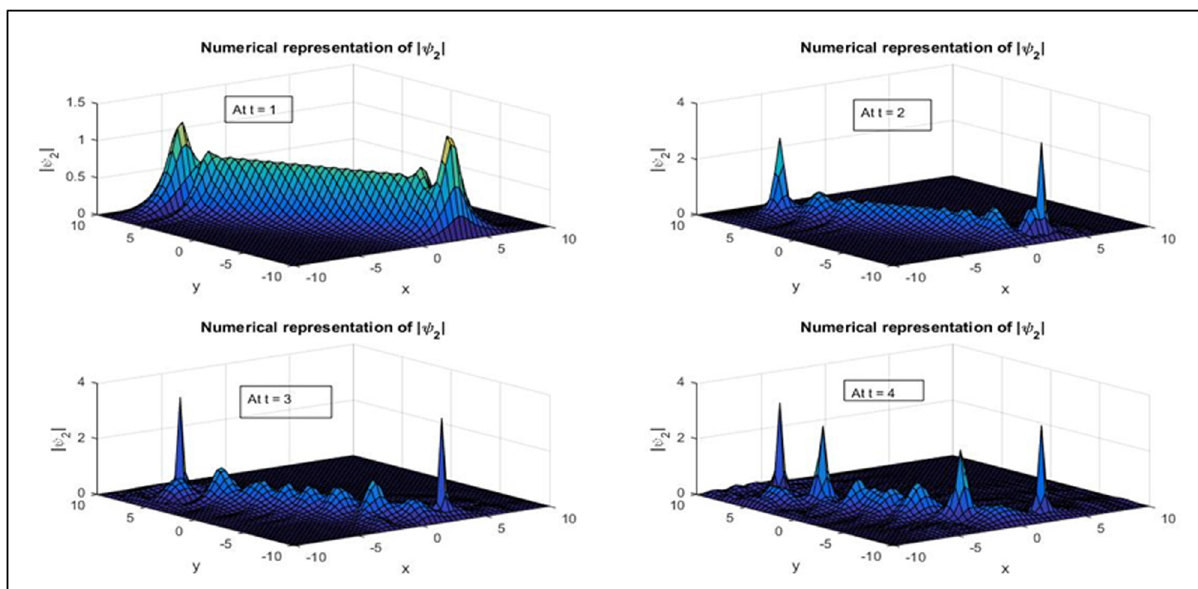
Figure 14: Representation of numerical solution of second - wave amplitude with = N 51 ,